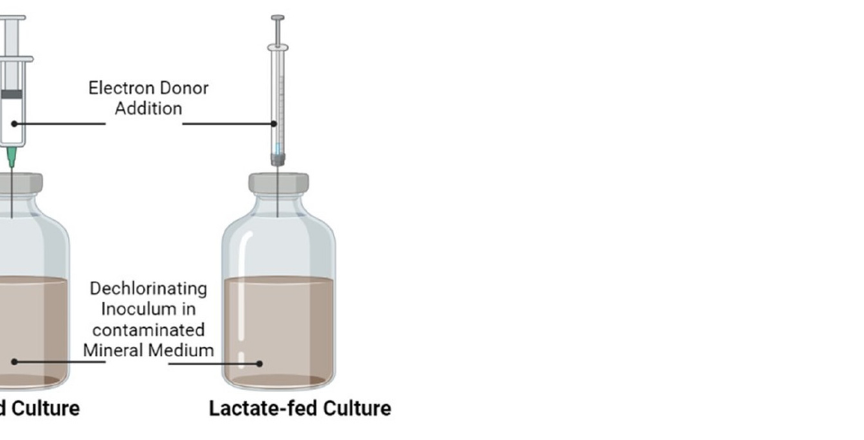
Figure 2. The schematic draw of the “Biotic H-cell” reactor.